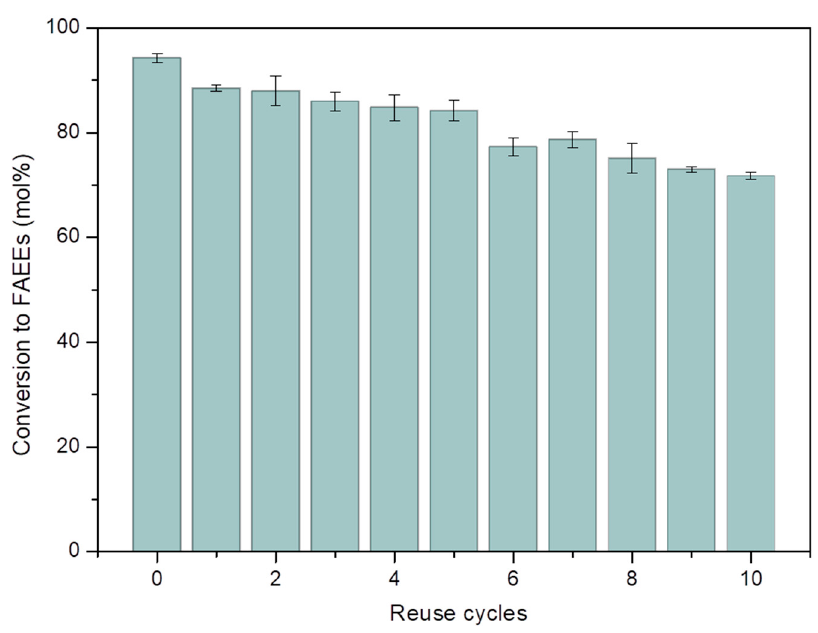
Figure 6. Reuse of combi-lipase 25:75 SBA-15-NH2G-CalB:SBA-15-NH2G-PC.